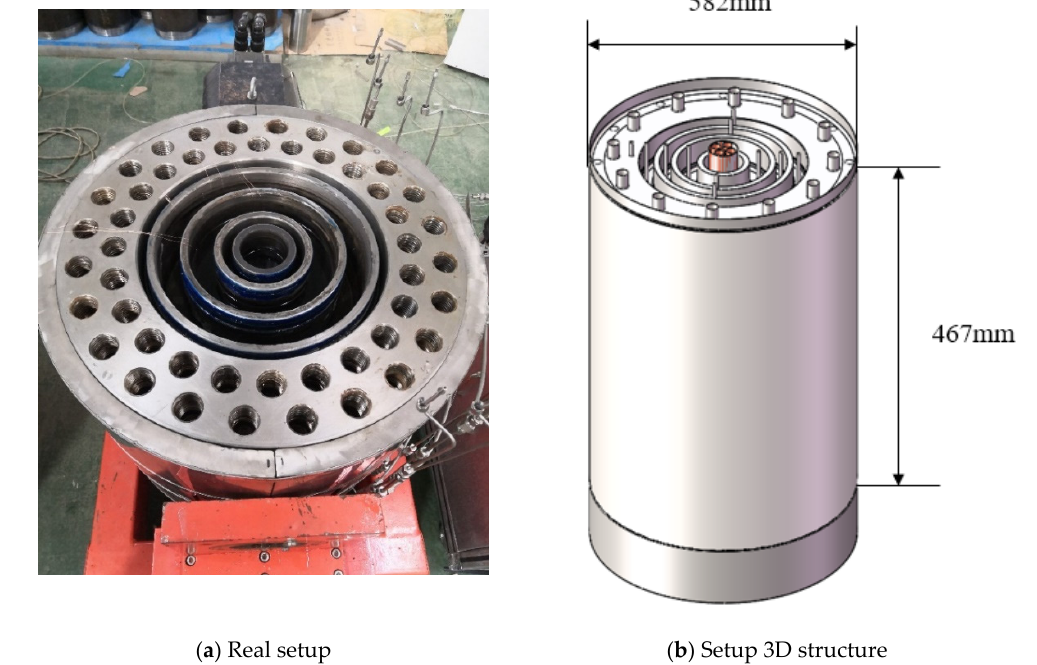
Figure 2. APB and casing-cement cementing load test setup.